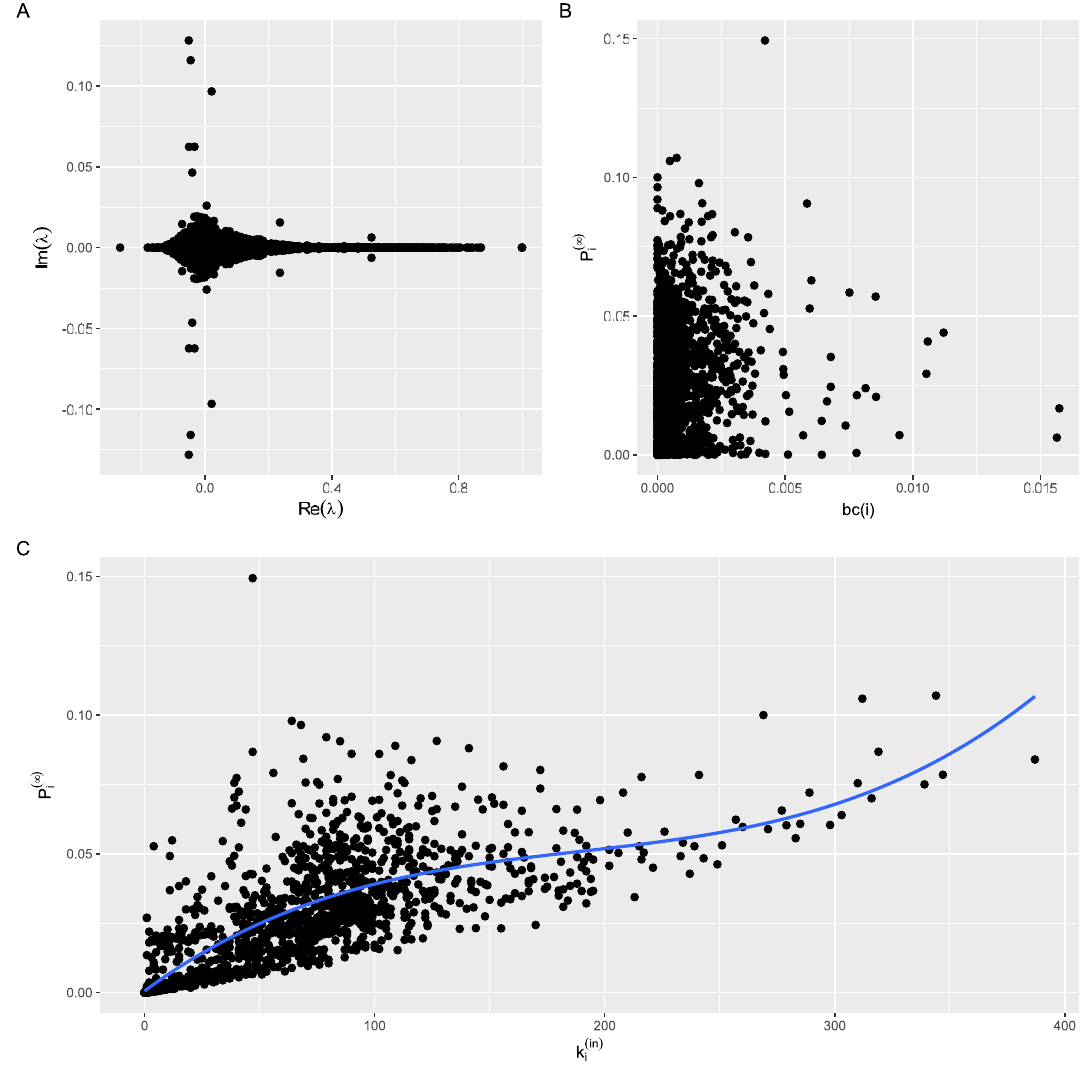
Figure 8. ( A ) eigenvalues (cid:31) of W ( out ) fulfilling Eq. (6), ( B ) components P ∞ i of the eigenvector � P ∞ with eigenvalue (cid:31) = 1 as a function of bc ( i ), ( C ) components P ∞ i of the eigenvector � P ∞ with eigenvalue (cid:31) = 1 as a ( in ) function of k i